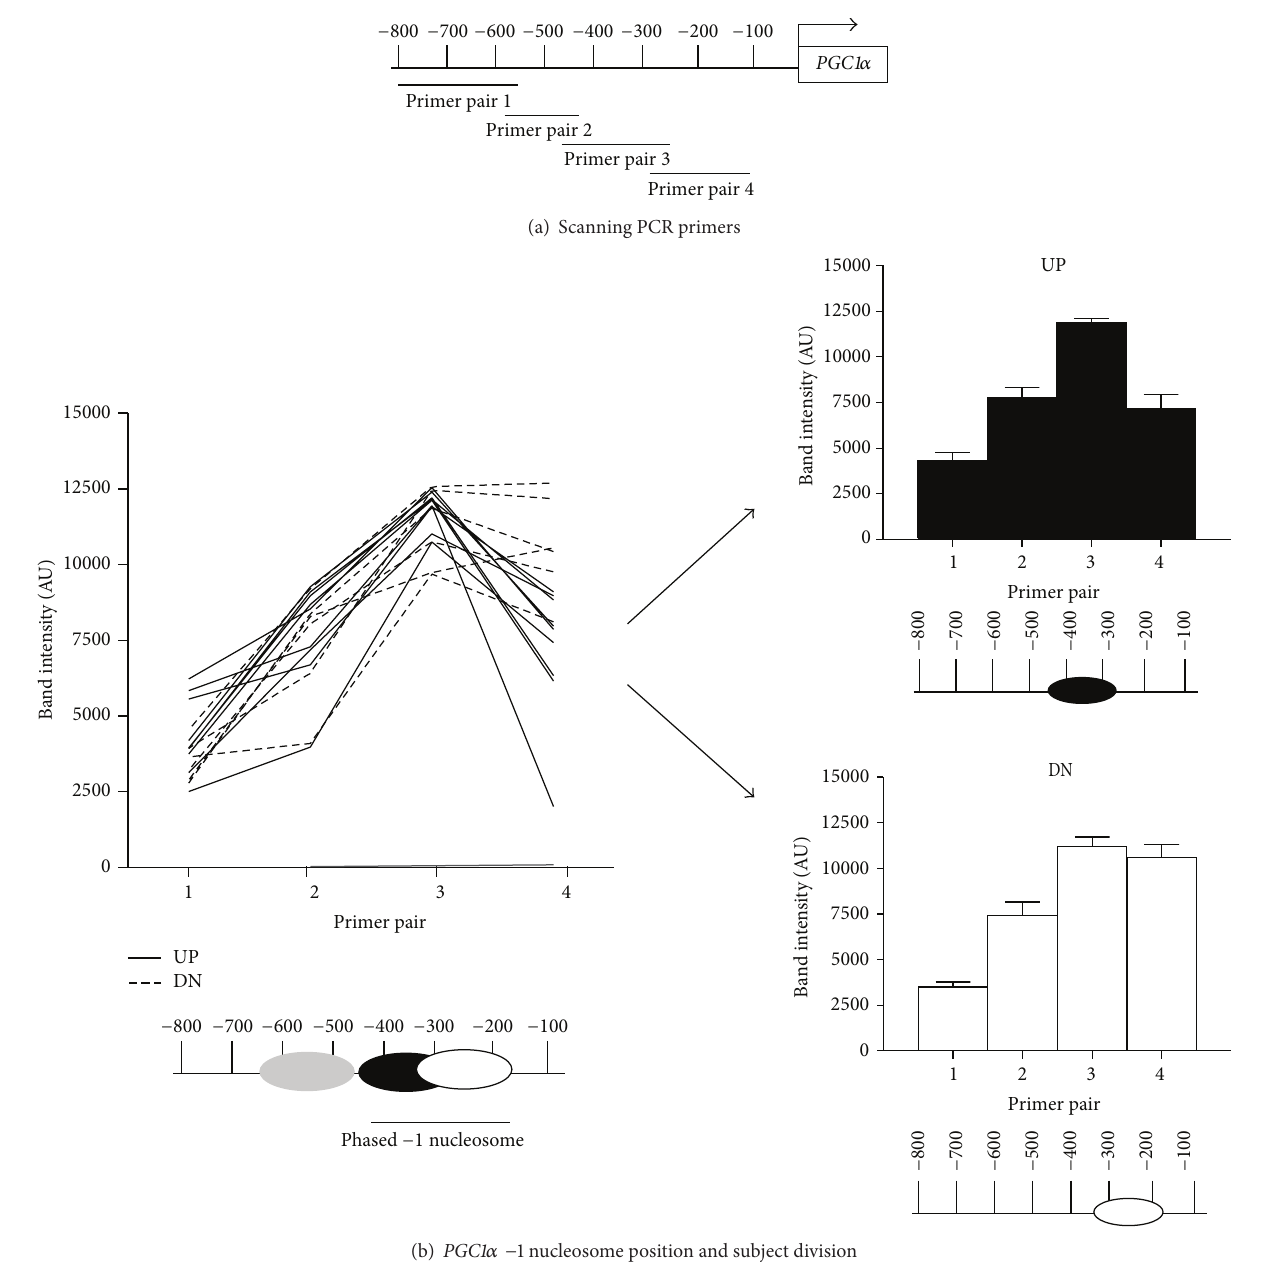
Figure 1: PGC1 𝛼− 1 nucleosome position. (a) Scanning qPCR was performed using four overlapping primer pairs targeted to the PGC1 𝛼 promoter region from approximately the − 800 nt to the − 100nt and depicted in the schematic. (b) Nucleosome positions were determined based on densitometry results and plotted as a line graph for each individual. All participants showed similar amplification with primer pairs 1 and 2, depicted as an upstream nucleosome (gray). Similar amplification was also seen with primer pair 3 but not with primer pair 4. This amplification pattern is depicted as a phased − 1N positioned between − 170nt and − 440 nt (white and black) below the line graph. Based on the phased − 1N position, participants were divided into two experimental groups shown on the right: upstream (UP, black) and downstream (DN, white), and densitometry results for each group are shown as mean ± SEM in the bar graphs. − 1N for UP and DN is depicted beneath each bar graph. All nucleosome positions are depicted relative to the transcriptional start site (TSS).